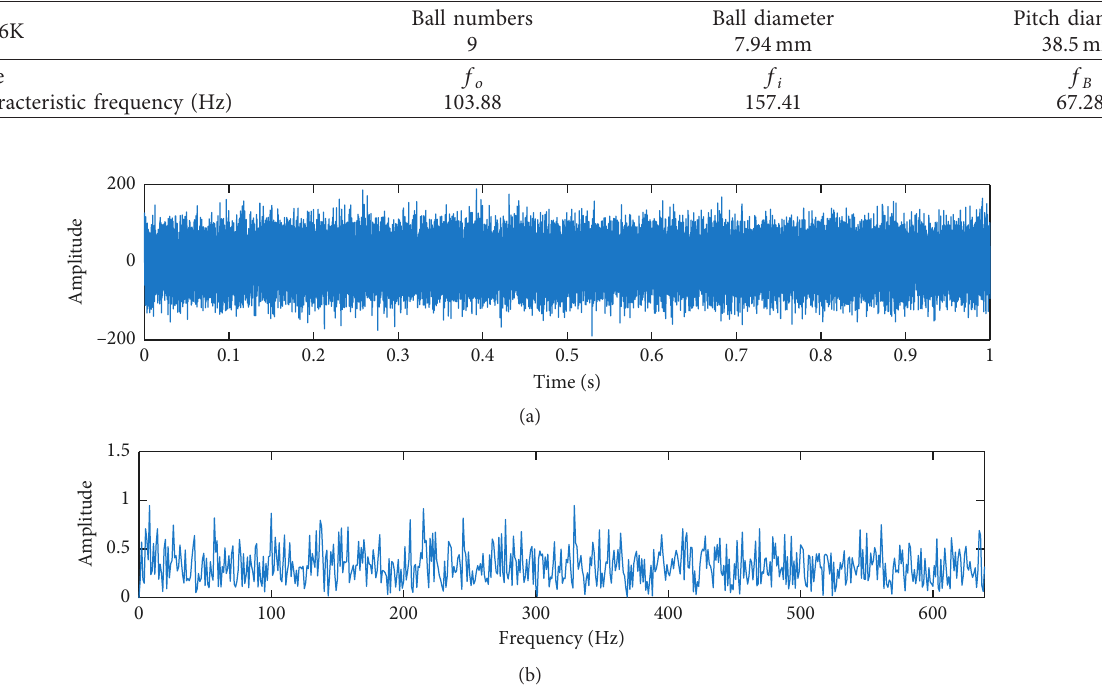
Figure 14: The experimental bearing vibration data of the test rig: (a) waveform; (b) envelope spectrum.